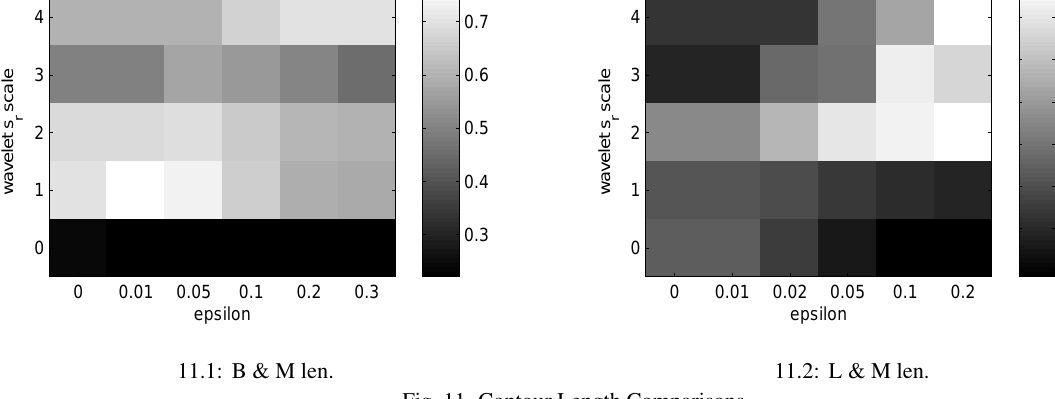
Fig. 11. Contour Length Comparisons. Table 7. Nearness Measures of L & M images based on contour